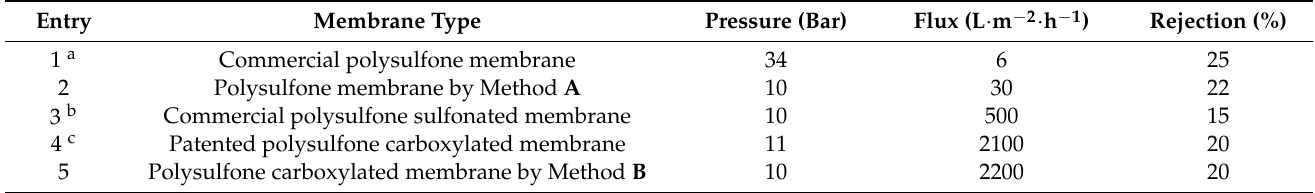
Table 1. Comparison between laboratory prepared membranes and commercial